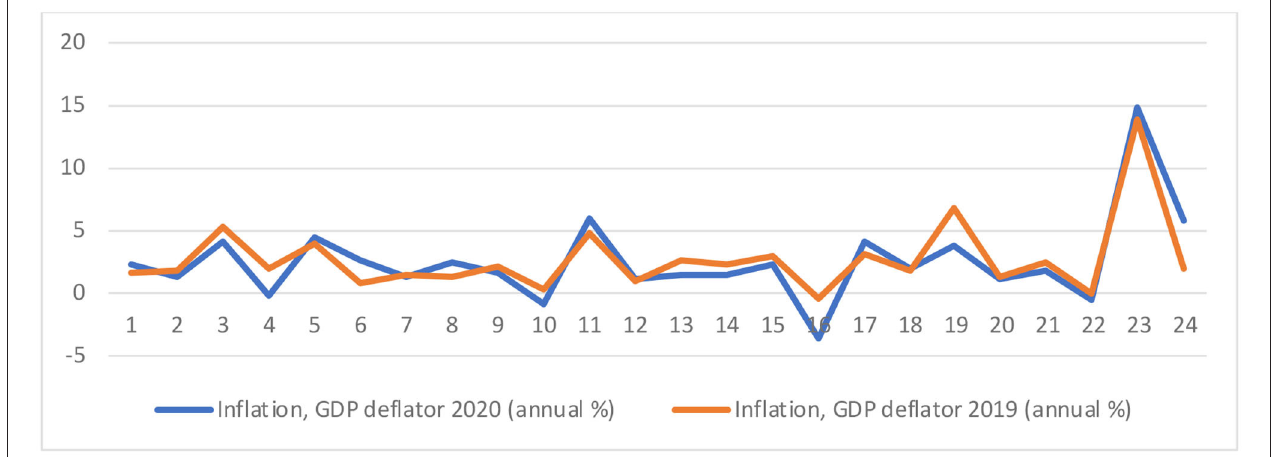
FIGURE 4 | Comparative analysis of gross domestic product (GDP) deflator 2020 and GDP deflator 2019. Source: Author’s Calculations.